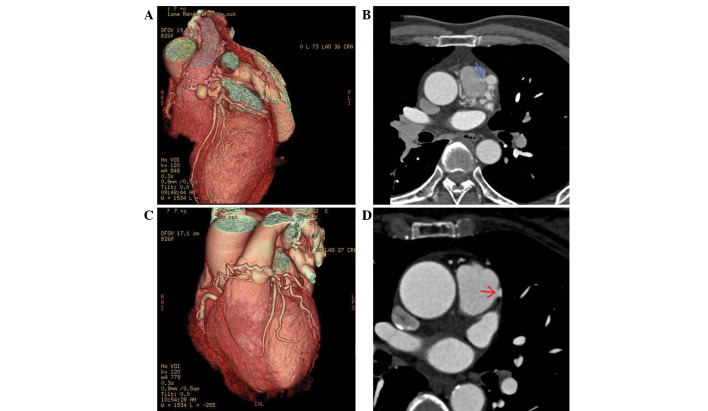
(A) VR image shows an aneurysm and tortuous vessel communicating with the proximal LCA and the PA in a 51-year-old male. (B) MIP image shows a high-density jet flow (blue arrow) directly injecting into the main PA. (C) VR image shows an aneurysm and tortuous vessel communicating with the proximal RCA and the PA in a 62-year-old female. (D) Axial image shows a PA artery wall defect (red arrow). LCA, left coronary artery; RCA, right coronary artery; VR, volume rendered; PA, pulmonary artery; MIP, maximum intensity projection.